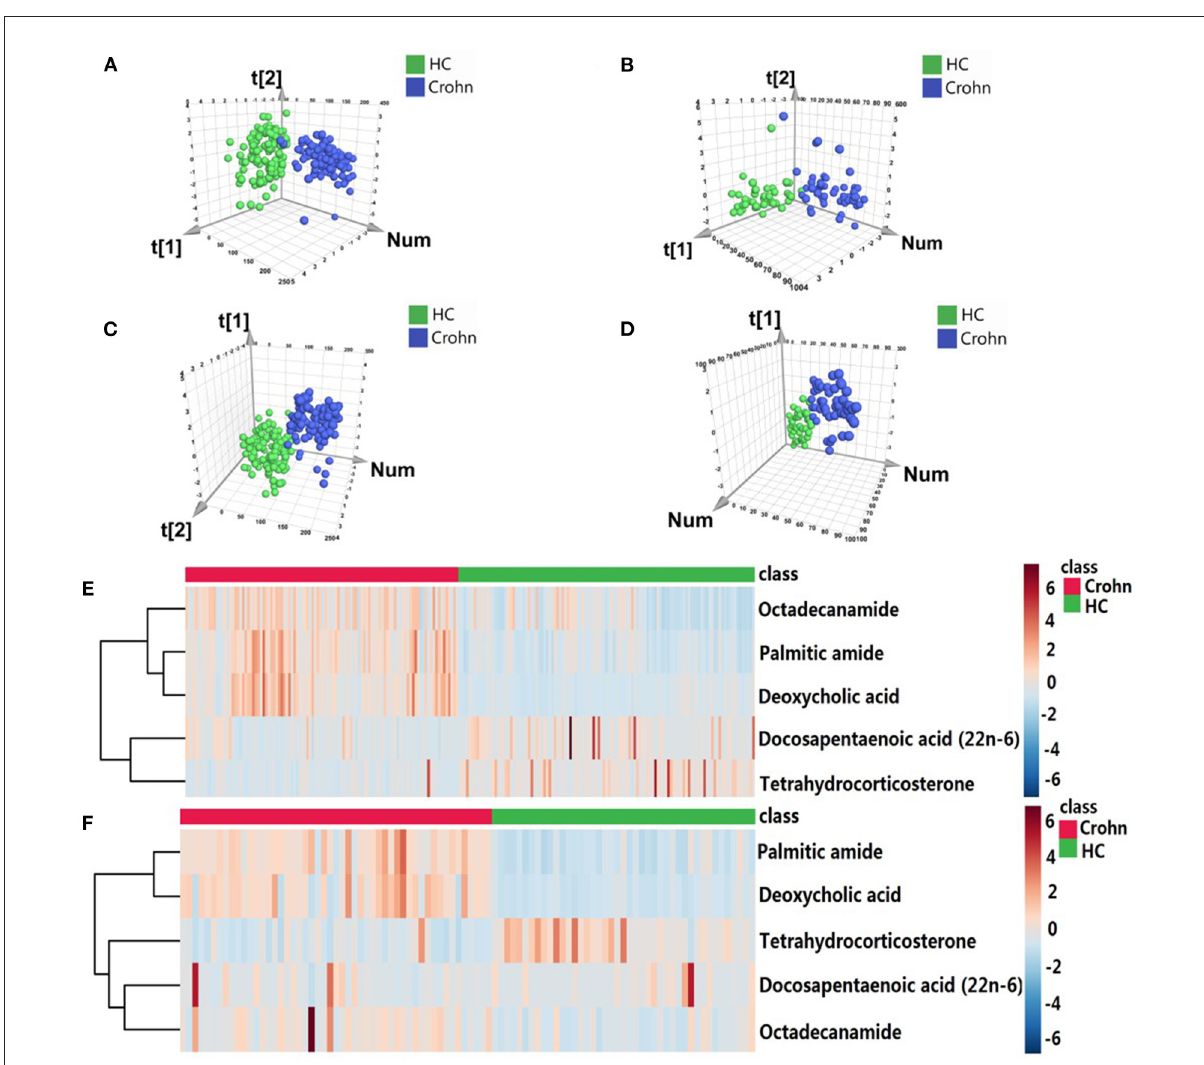
FIGURE4 The performance of five overlapping metabolites for classification. The scatter plots of PCA based on five metabolites in the (A) discovery and (B) validation cohorts. The PLS-DA scatter plots of five metabolites in the (C) discovery and (D) validation cohorts. Heatmap of cluster analysis of each metabolite in the (E) discovery and (F) validation